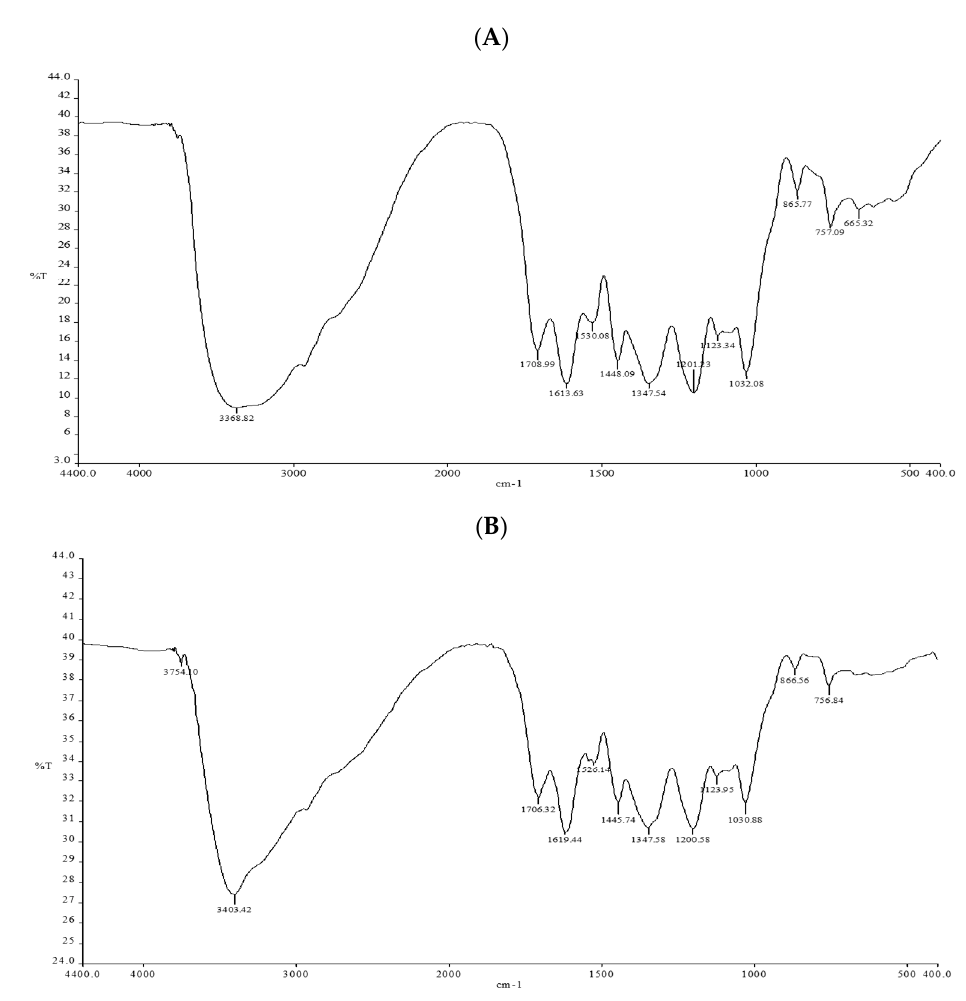
Figure 6. FTIR of ( A ). Aqueous A. nilotica pod extract, ( B ) Biosynthesized AgNPs prepared with aqueous extract of A. nilotica pods. Table 2. FT-IR spectra showing probable functional groups of aqueous A. nilotica pod extract and A. nilotica -AgNPs extract.